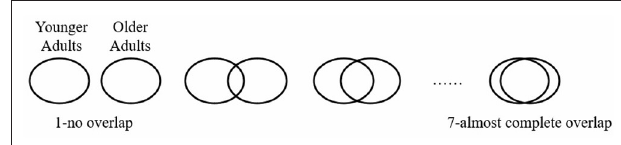
FIGURE 1 | Measuring levels of Inclusion of Outgroups in the Self